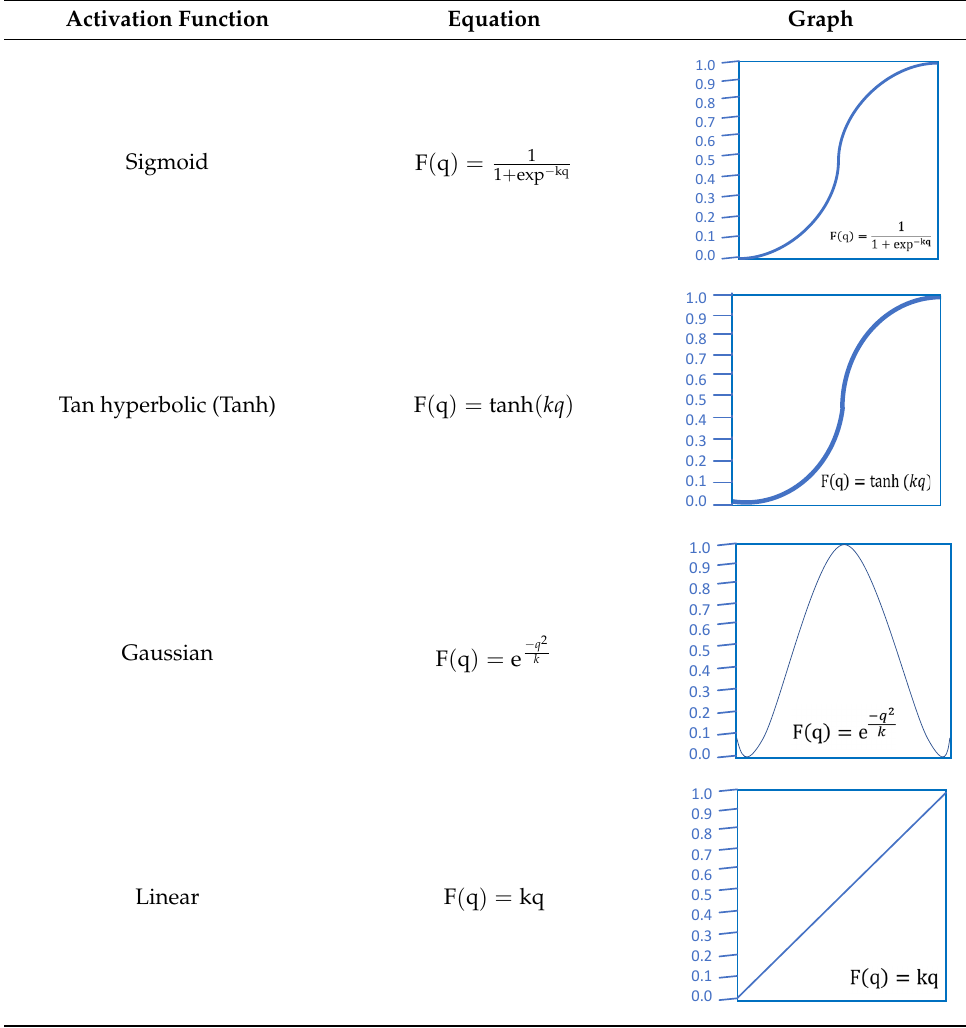
Table 1. Activation functions used in this work.